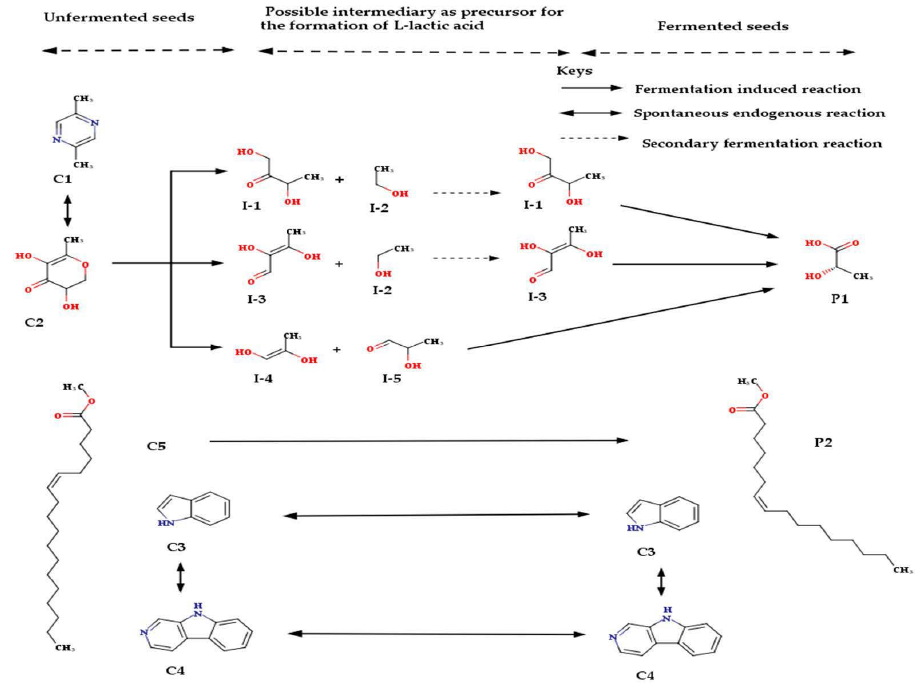
Figure 2. The proposed transformation mechanisms for the major molecules identified in the unfermented kernels of C. albidum during fermentation. Keys: C1: 2,5-dimethylpyrazine; C2: 3,5-dihydroxy-6-methyl-2,3-dihydro-4 H -pyran-4-one; C3: Indole; C4: Norharman; C5: Methyl petroselinate; P1: L -Lactic acid; P2: formyl 7 E -hexadecenoate; I-1: 1,3-dihydroxybutan-2-one; I-2: